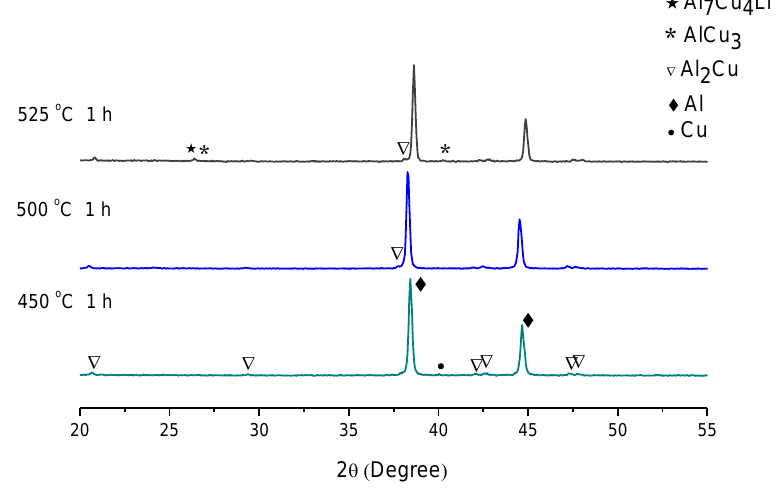
Figure 11. X-ray diffraction patterns of compacts heat treated at different